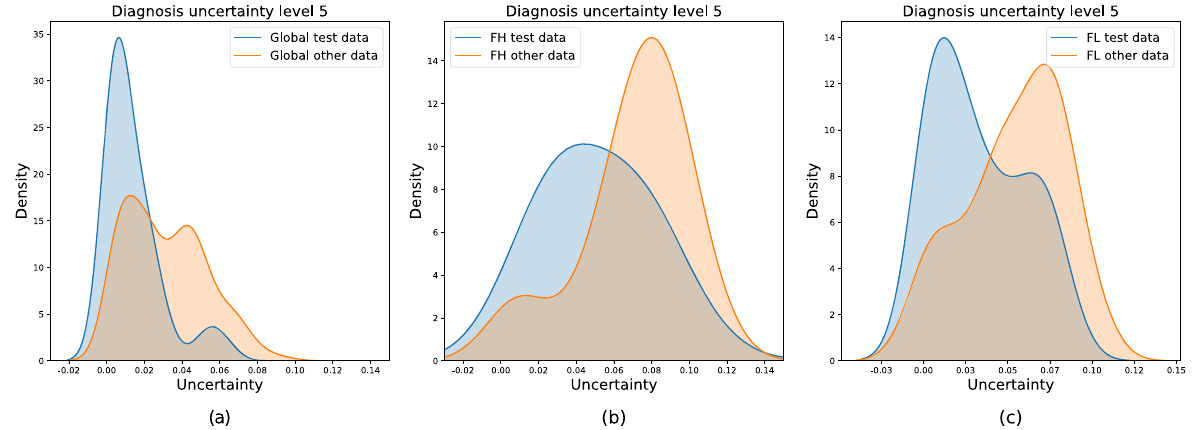
Fig. 7 Comparison of uncertainty distributions between familiar test data (composed by FL and FH) and other unfamiliar data (non-FL/FH). Uncertainty distributions are shown for global ( a ) and class-speci fi c ( b and c ) diagnosis. We separate test distribution (blue curves) and unfamiliar distribution (orange curves) on each plot. Non-FL/FH slides are diagnosed with higher values of uncertainty than the one encountered in usual FL/FH test data.